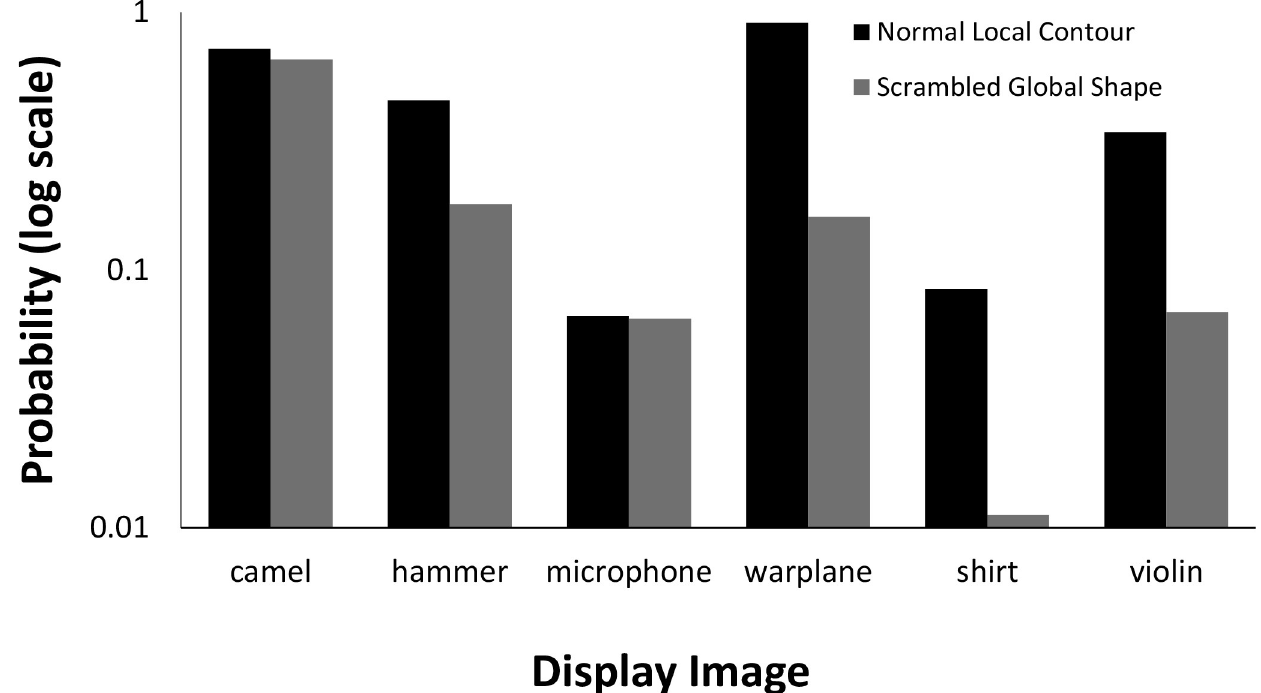
Fig 25. VGG-19 for unscrambled and part-scrambled images. Bars show probabilities for correct responses for each of the objects. Probability is plotted on a logarithmic scale to make small values visible.